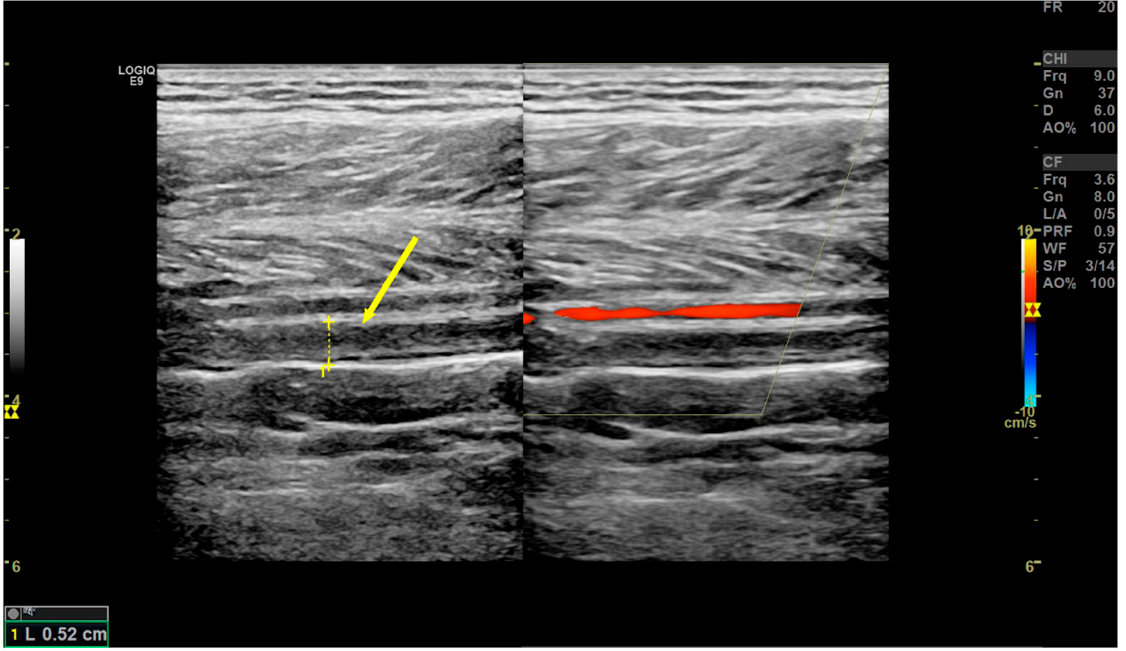
Figure 1. DVT in Doppler ultrasonography (yellow